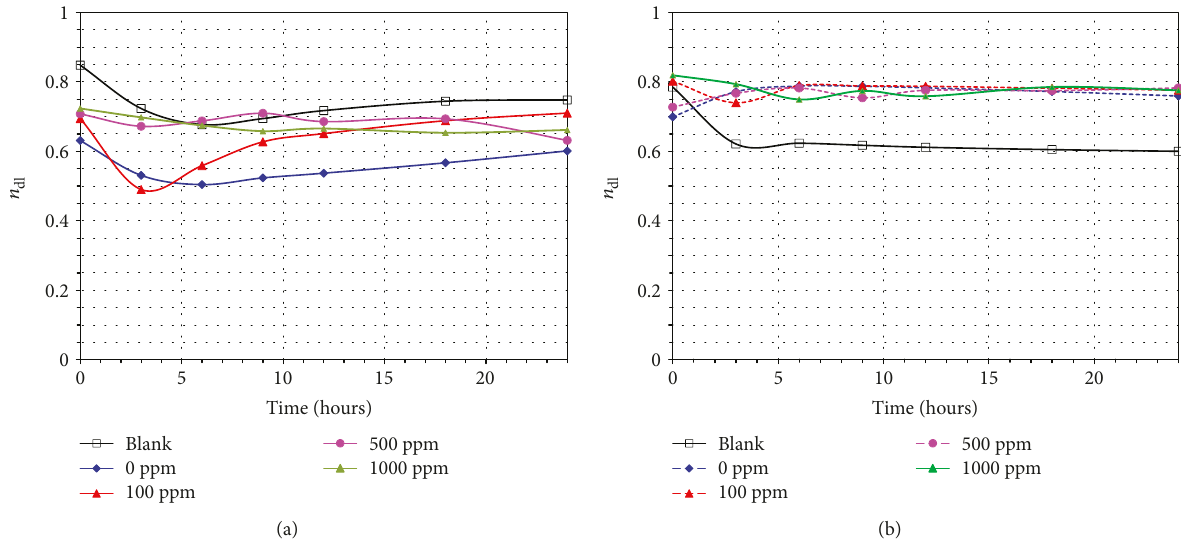
Figure 14: Evolution of the (a) n concentrations of